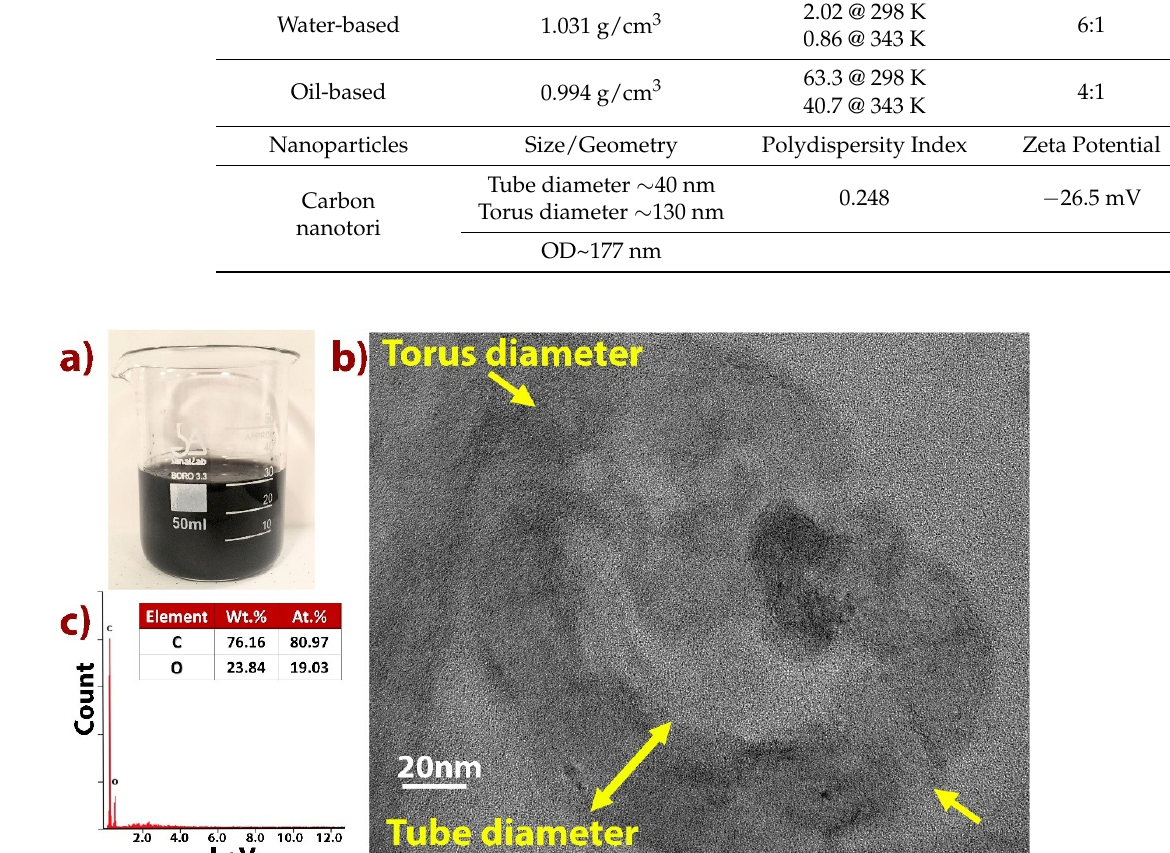
Figure 1. ( a ) Carbon nanotori structures suspended within DiW; ( b ) TEM of analyzed carbon nanotori; and ( c ) EDAX analysis of carbon nanotori.